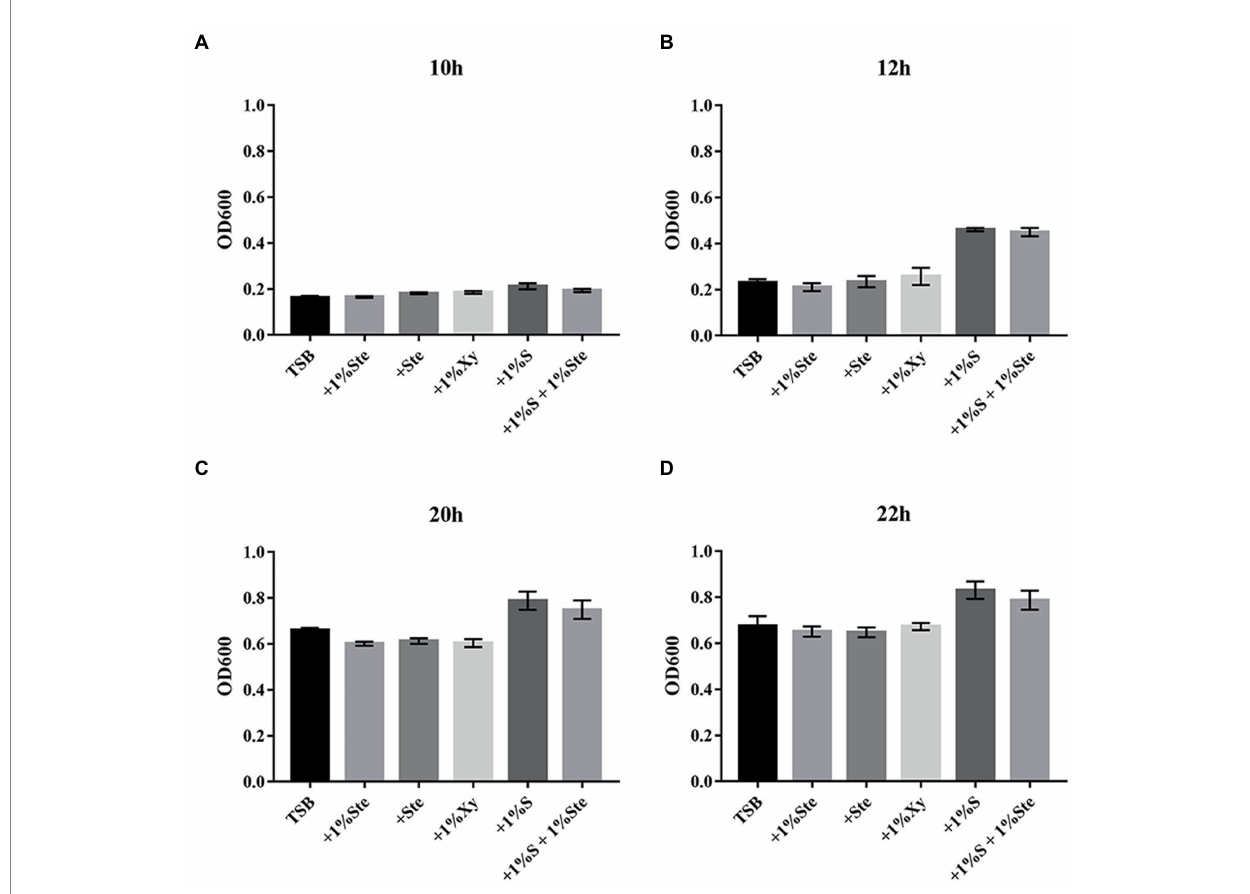
FIGURE 1 The effects of stevioside treatment on dual species growth of Streptococcus mutans and Candida albicans in planktonic cultures. (A–D) The dual- species planktonic growth at 10, 12, 20, and 22 h was represented by the mean OD 600 nm ± SD for different media. After extending the incubation time, the mean OD values rose significantly, especially in sucrose-added groups. +1% Ste., TSB medium supplemented with 1% stevioside; +Ste., TSB medium supplemented with stevioside of the same sweetness as 1% sucrose; +1%Xy, TSB medium supplemented with 1% xylitol; +1% S, TSB medium supplemented with 1% sucrose; +1% S + 1% Ste., TSB medium supplemented with 1% sucrose and 1%